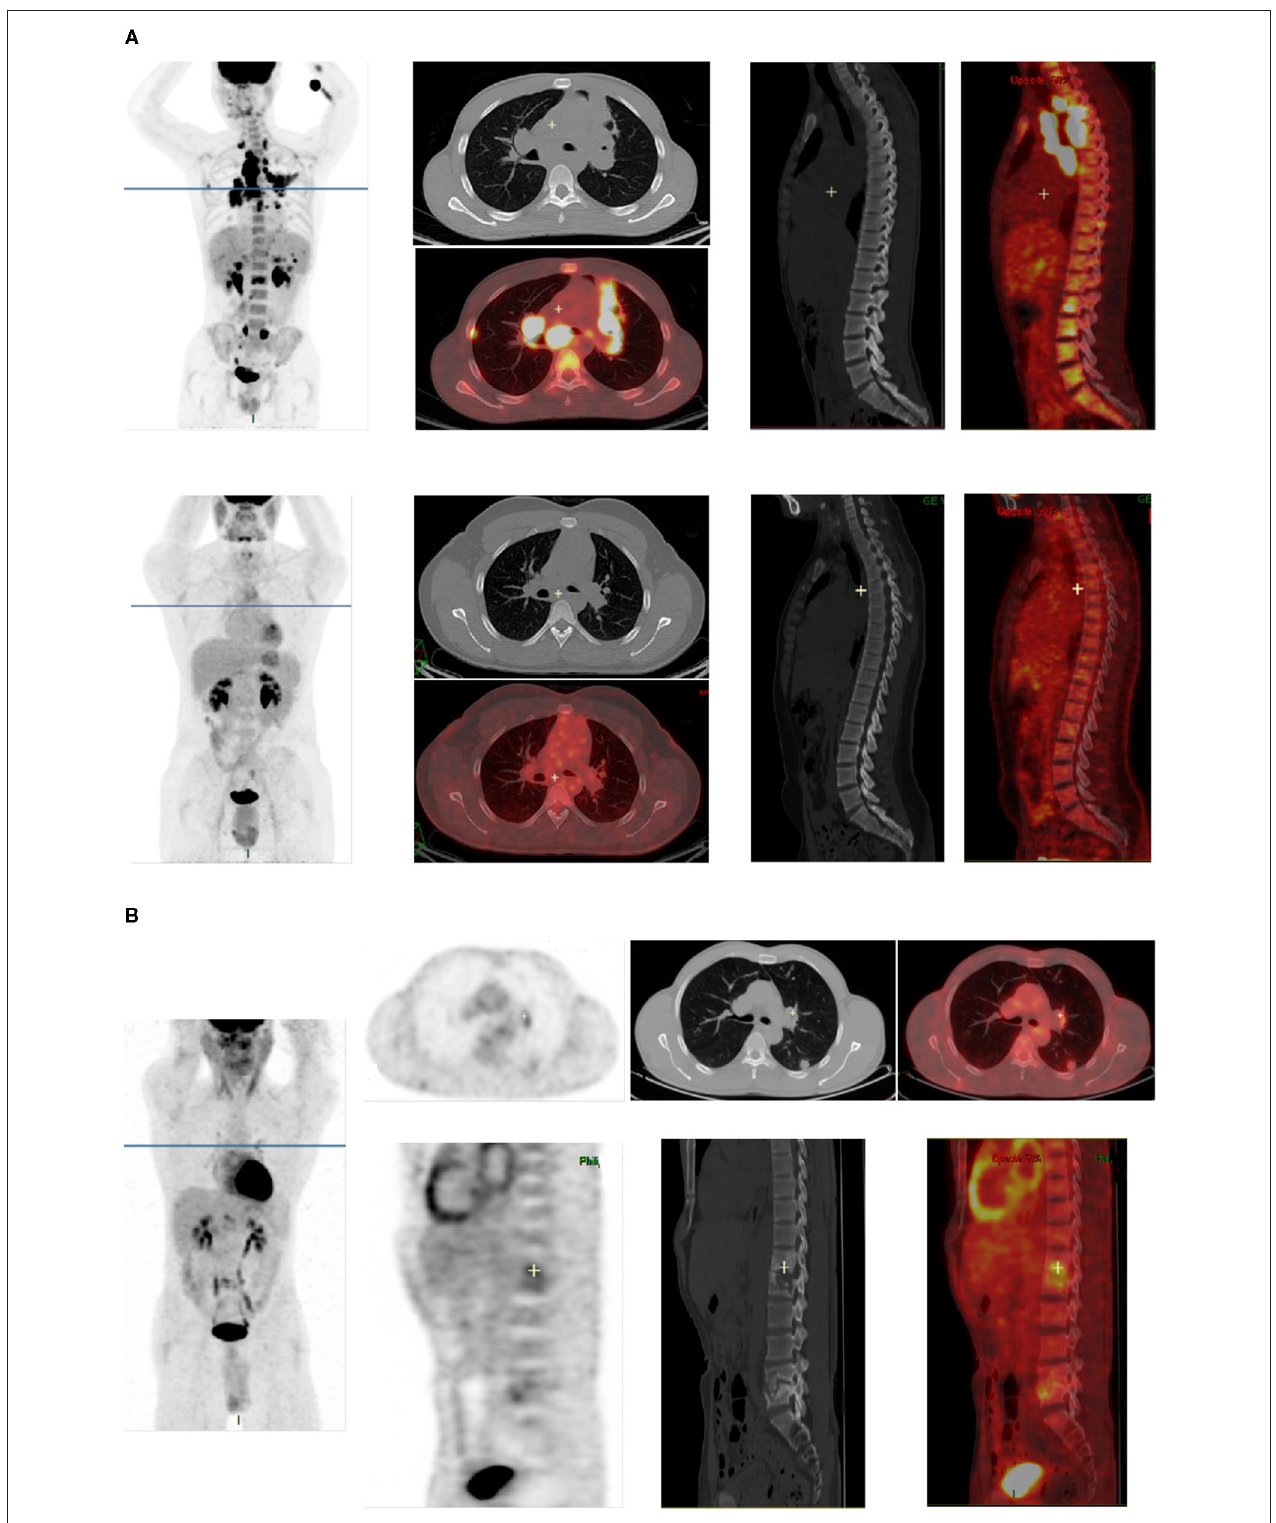
FIGURE 3 | Examples of [ 18 F]FDG-PET/CT images in two patients cured at the end of treatment. (A) PET1 and PET2 images of a patient cured at the end of treatment. All abnormalities seen on PET1 (lung lesions, mediastinal lymph nodes, bone lesions in dorsal and lumbar spine) completely disappeared on PET2. (B) PET2 images of a patient cured at the end of antibiotherapy, showing residual FDG uptake in cured lesions [left lung, left hilar lymph node, and spine (T12, L1, and L5)].